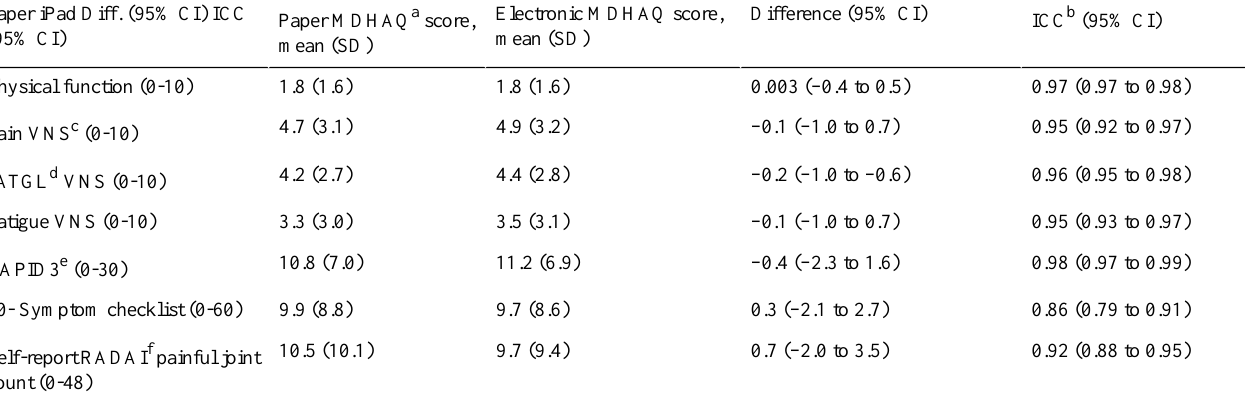
Table 2. Scores and test-retest reliability of patient-reported measures on the MDHAQ in paper versus electronic format for patients seen in routine care